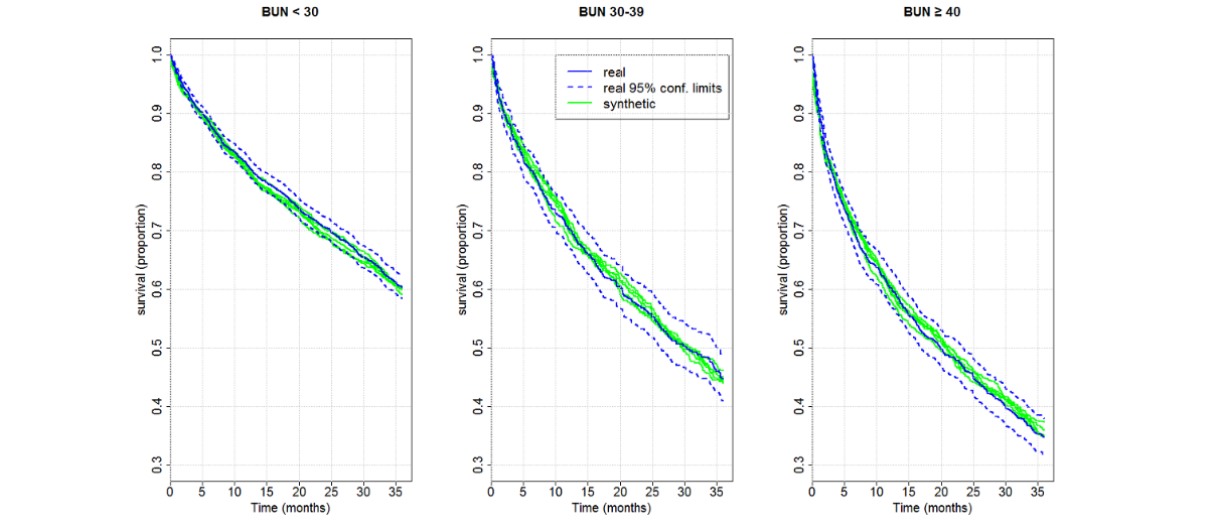
Figure 4. Kaplan-Meier three-year survival curves by admission BUN level, as estimated from the real data (in blue) and from five repeatedly generated synthetic datasets (in orange). The survival curves estimated from the synthetic sets were very close to the curve estimated from the real data.